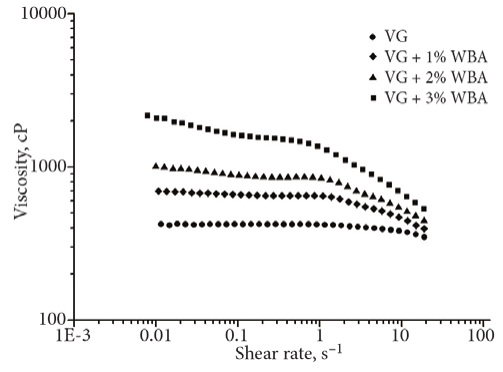
Figure 2. Viscosity results at 60 °C